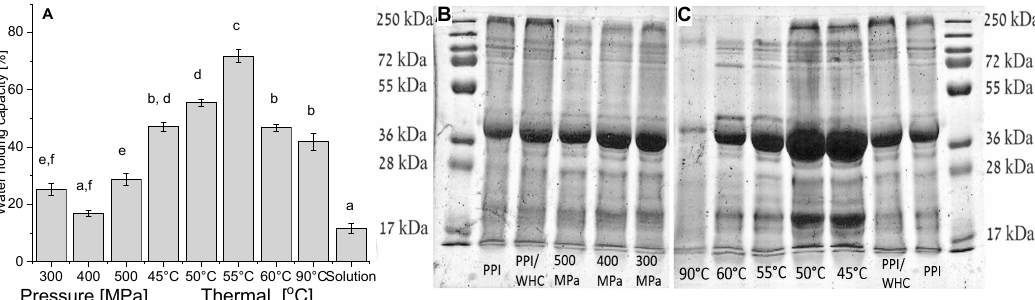
Figure 6. Water holding capacity ( A ) of the heat and pressure induced gels at pH 3. SDS-PAGE of potato proteins that were released from pressure ( B ) and thermal ( C ) induced gels (pH 3) during the Water Holding Capacity (WHC) experiment. The buffer released from the pressure-induced gel was diluted by 20, from thermally-induced gels, except for 90 °C, the buffer was diluted by 7, from thermally-induced gels formed at 90 °C the buffer was diluted by 2, the untreated potato solution after the same experimental set-up as the gels (PPI/WHC) was diluted by 40, and 14 µg PPI was loaded. Different letters (in A ) indicate significant differences ( p < 0.05, n = 5), error bars indicate standard deviation.